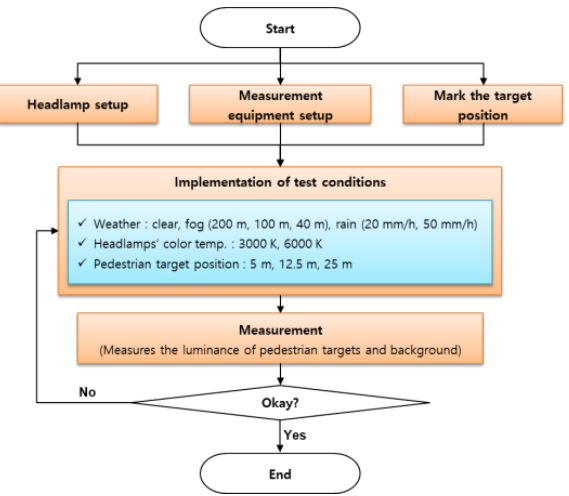
Figure 4. Test procedure for convertible color temperature headlamps.